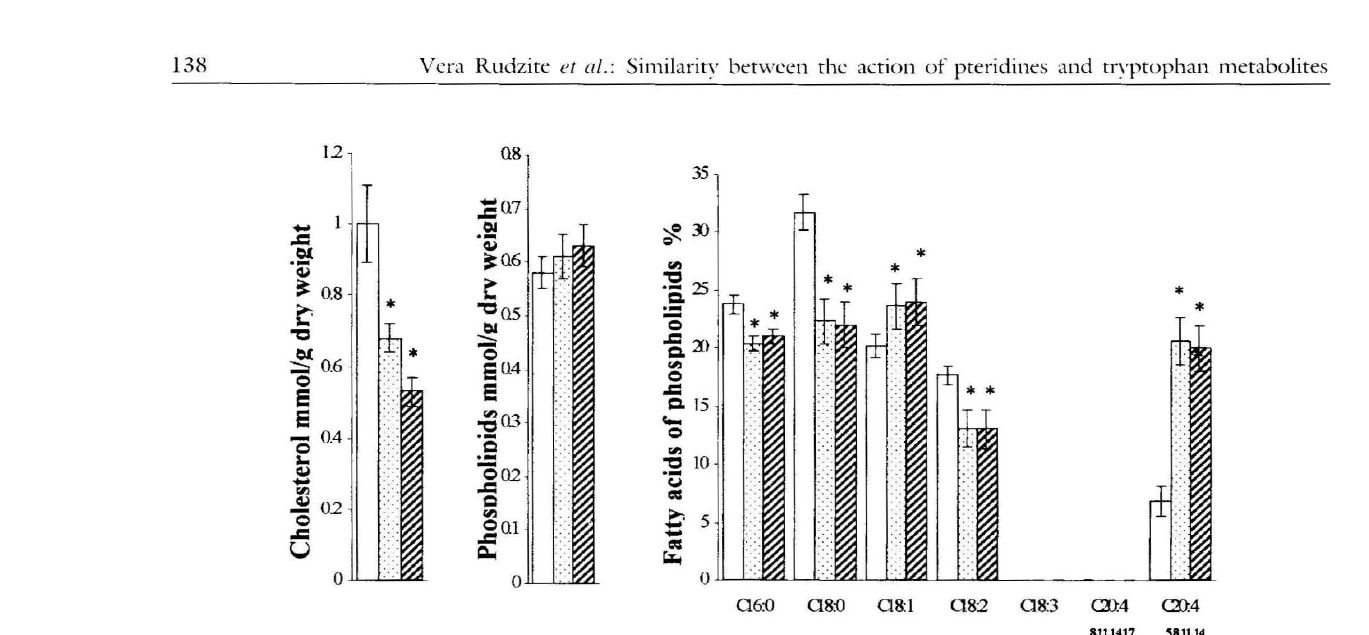
Figure 8. Concentrations (mean±S.D.) of cholesterol and phospholipids as well as Eltty aeid content of phospholipids (in percent; mean±S.D.) in controls (open bars) and in samples with l.8 l1mol/g wet weight 3-hydrm.:ykynurenine (dotted bars) and in samples with 4 nmol/g wet weight 3-hydroxykYl1urenine (hatched bars). Samples of rat liver tissue homogenates were used to test tClr phospholipid biosynthesis ill vitro. Incubation medium: Krebs - Ringer - phosphate butler containing 0.3% albumin (pH=7.4), fatty acid mixture and glycerol. Samples were incubated twice fClr 4 h at 37°C. "The changes are statistically significant (p<0.05 -p<0.001).